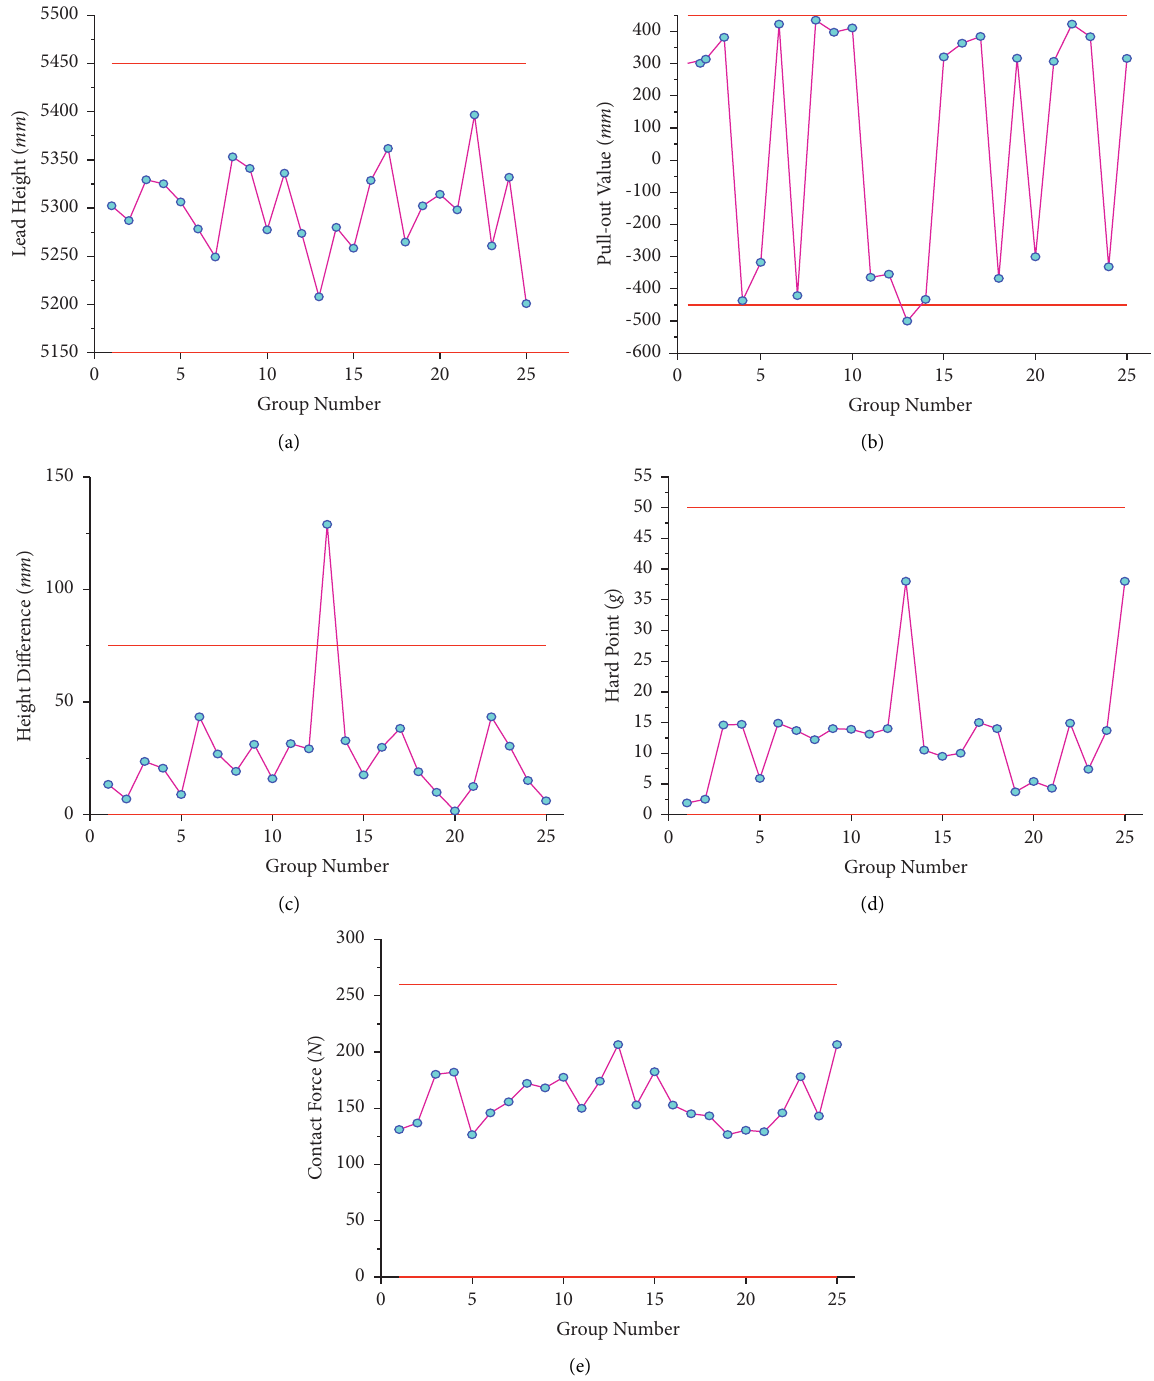
Figure 1: Changes of catenary parameters of one section. (a) Lead Height/mm; (b) pull-out value/mm; (c) height difference/mm; (d) hard point/(g); (e) contact